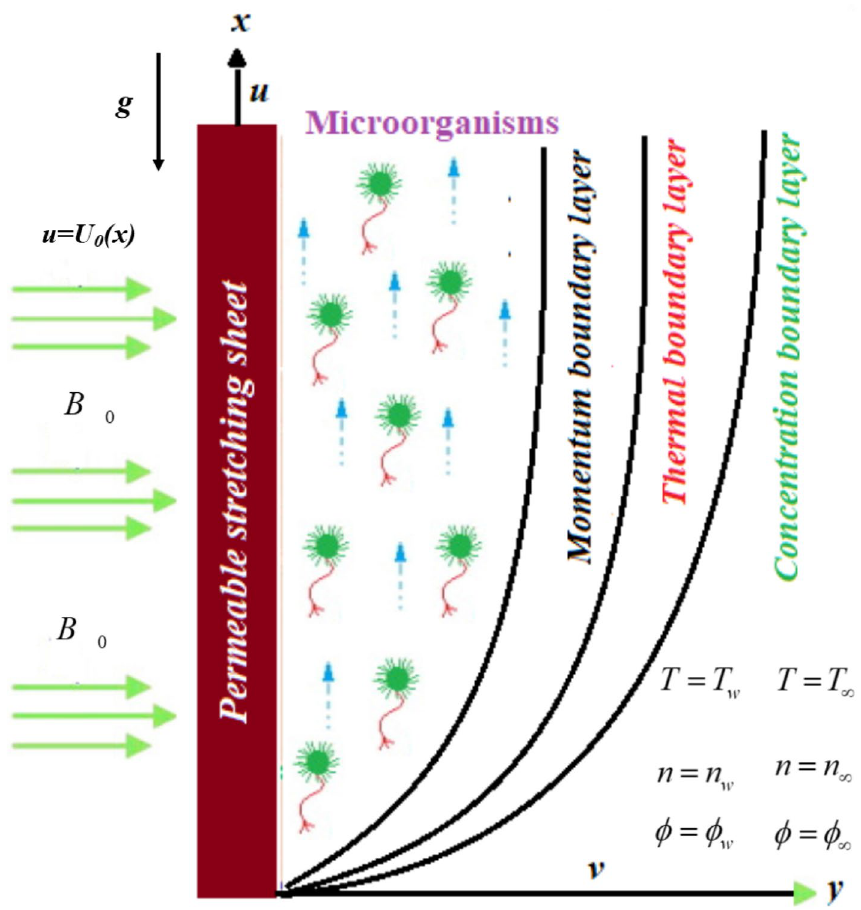
Figure 1. Fluid flow through vertical permeable